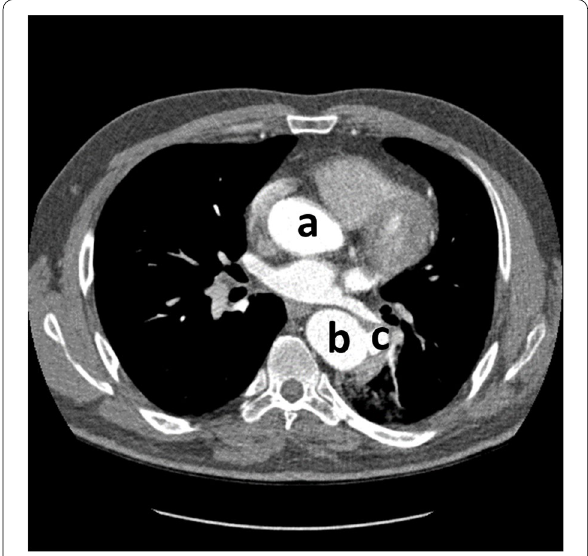
Fig. 2 Spiral CT angiography of the Thorasic Aorta revealed two outpouchings from tube graft and fistula to bronchial artery. a: ascending aorta, b: distal anastomosis site of tube graft to descending aorta, c: outpouching from distal anastomosis site of tube